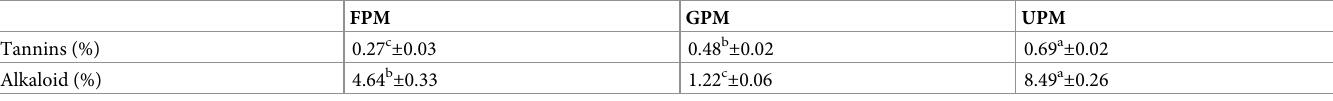
Table 2. Tannins and alkaloid concentrations in peanut meal processed by different